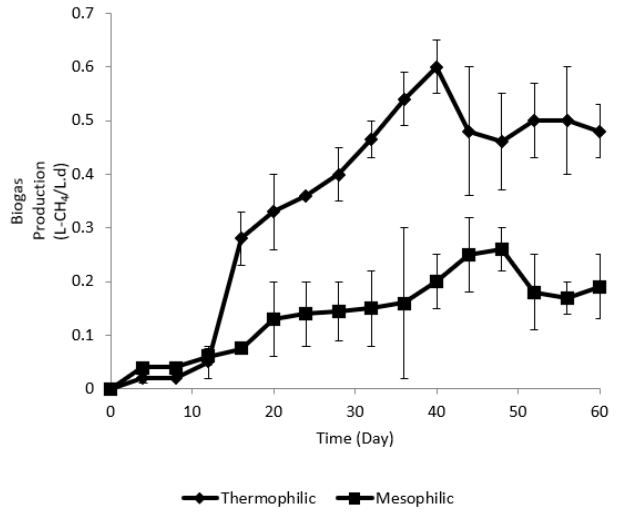
Figure 2. The range of biogas volume for thermophilic and mesophilic conditions during the acclimatization period. Notes: error bars show standard deviation of means (n = 3).